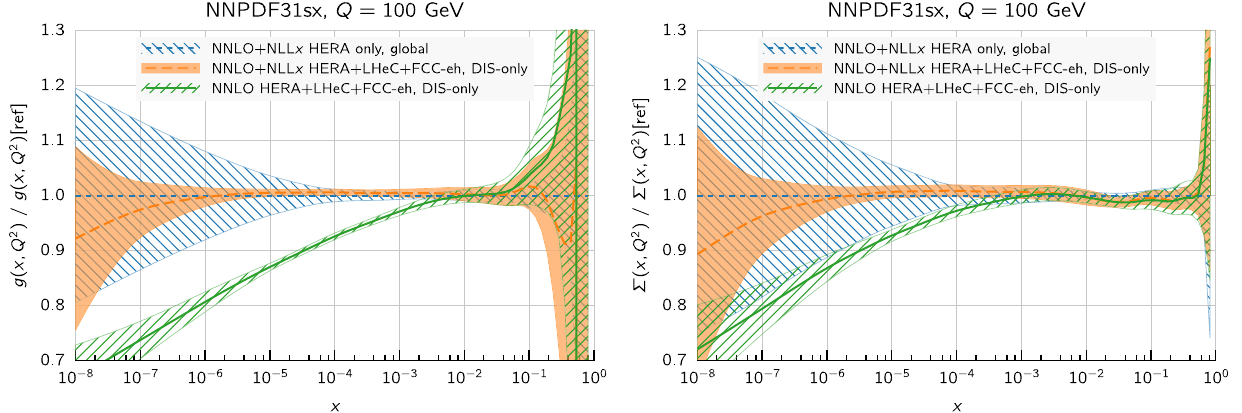
Fig. 36 Comparisonbetweenthegluon(leftplot)andthesinglet(right plot) PDFs in the NNPDF3.1sx NNLO+NNL x fits without and with the LHeC+FCC-eh pseudo-data on inclusive structure functions. For com-